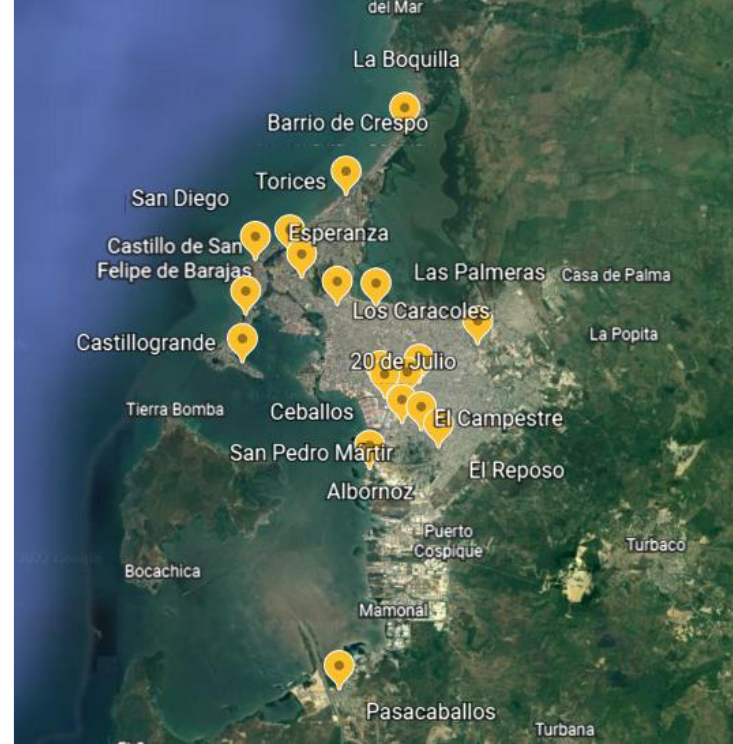
Figure 7. Sampling sites.